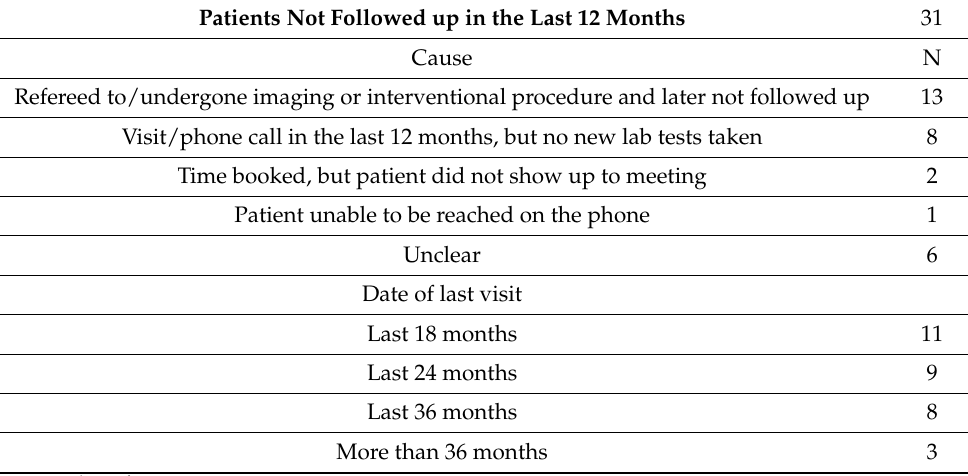
Table 4. Number of patients who were not followed up in the last 12 months, possible cause, and date of last visit.